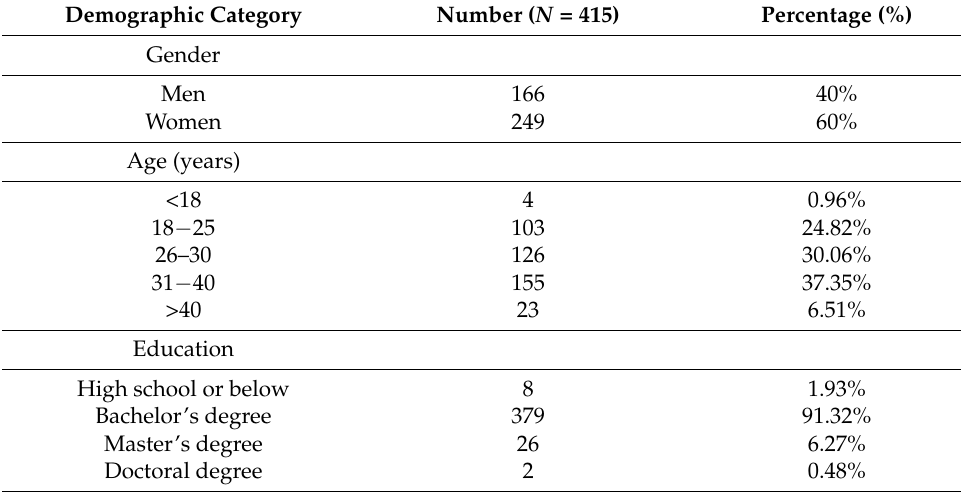
Table 2. Demographic information of study